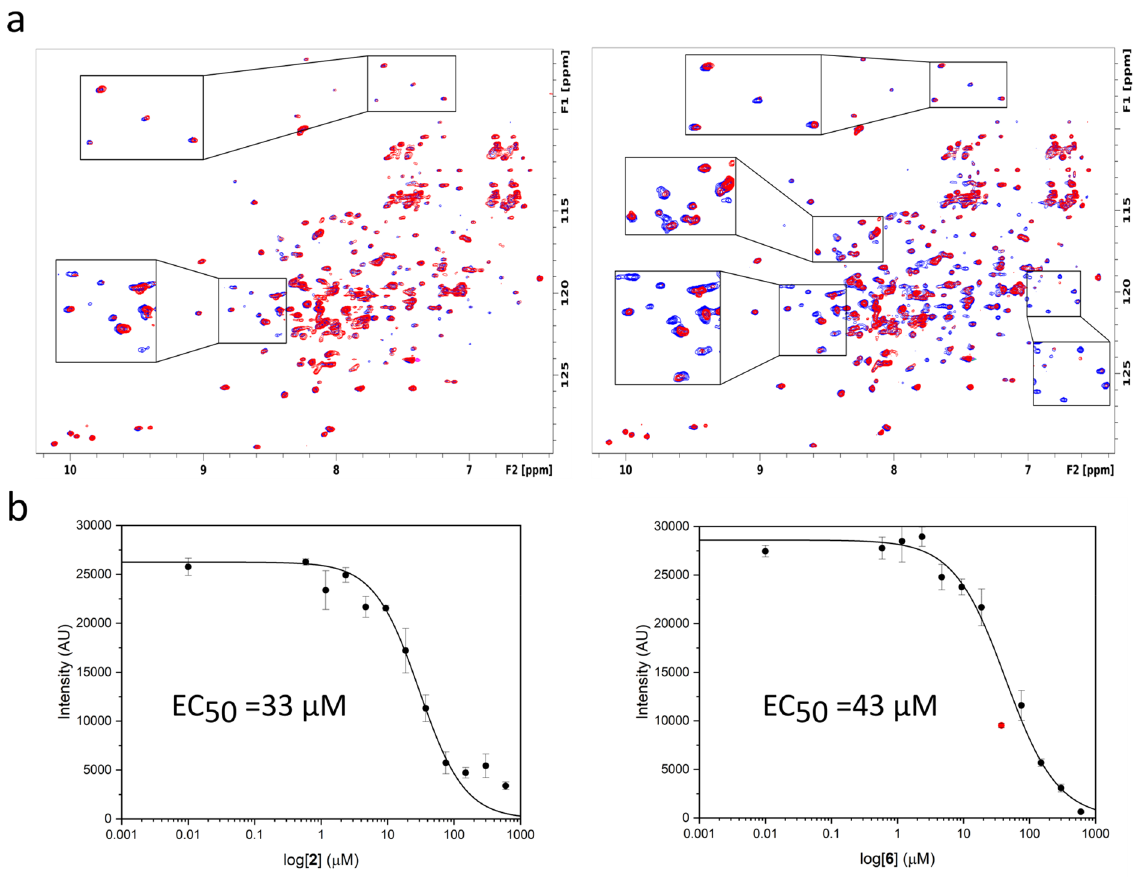
Figure 3. Orthogonal validation of HTS hits. ( a ) 1 H– 15 N 2D HSQC spectra of the 2 H, 15 N-labeled Tc PEX5 (blue) superimposed with spectrum after addition of hit compound 2 (left) and 6 (right) at 1:1 molar ratio (red). Zoomed views show significant spectral changes. ( b ) AlphaScreen dose-dependent displacement curves for 2 (left) and 6 (right). The error bars represent the standard error of n = 4 measurements.